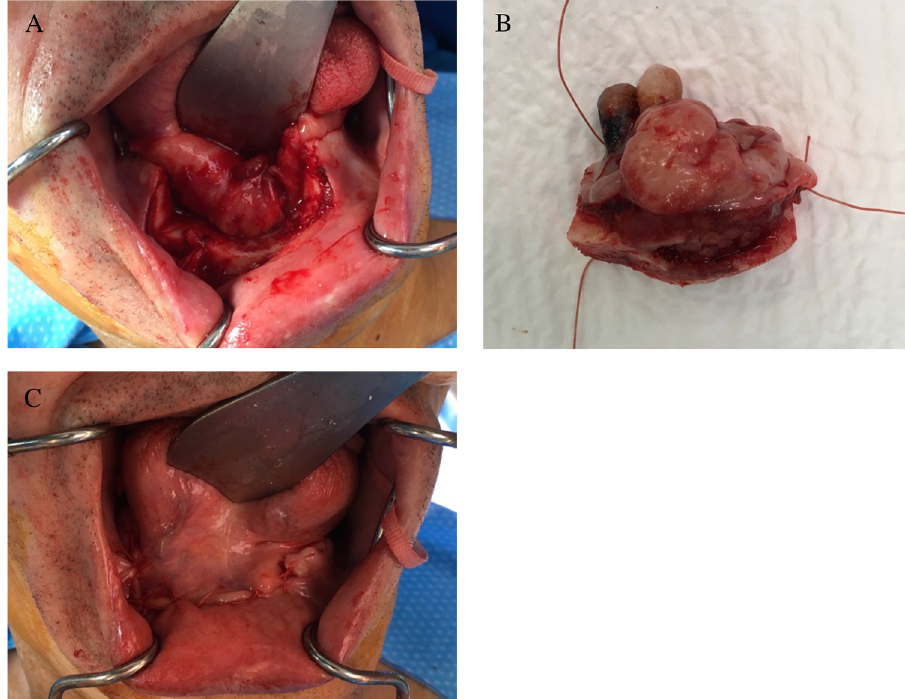
Fig. 3. Metastatic excision surgery. (A) Perioperative view of an uninterrupted partial mandibulectomy with preservation of the inferior alveolar nerve. (B) View of the excised section. (C) Post-operative view immediately after excision and closure of the